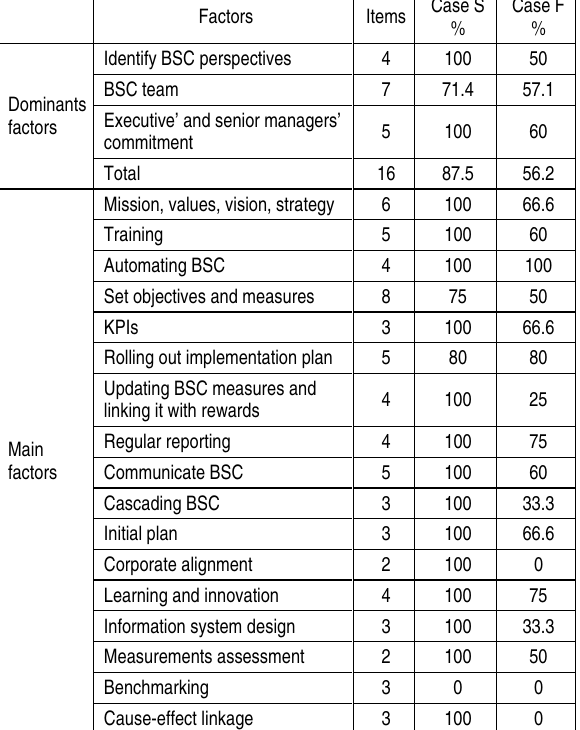
Table 1. Percentage of compliance with the criteria of Assiri and others (2006) by organizations S and F Case S Case F Factors Items %